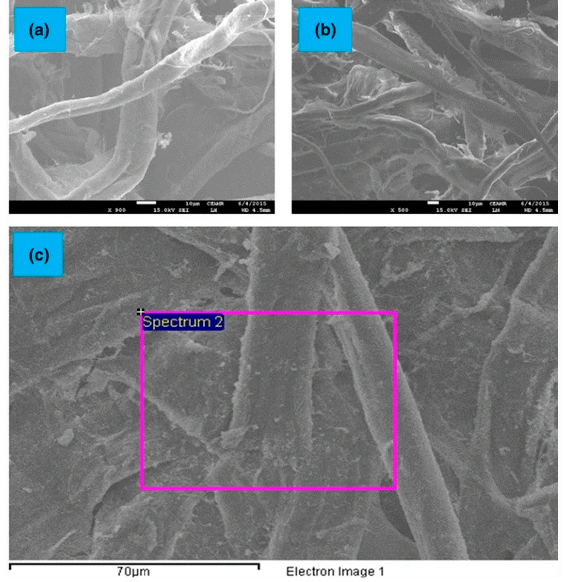
Figure 9. FE-SEM images of ( a ) filter paper (FP), ( b ) filter paper coated with 1% wt chitosan (CH-FP), and ( c ) Cu 0 loaded CH-FP [109] (Reprinted by permission from: Springer, Cellulose, Synthesis of zero-valent Cu nanoparticles in the chitosan coating layer on cellulose microfibers: Evaluation of azo dyes catalytic reduction, Kamal, T.; Khan, S.B.; Asiri, A.M., 2016).